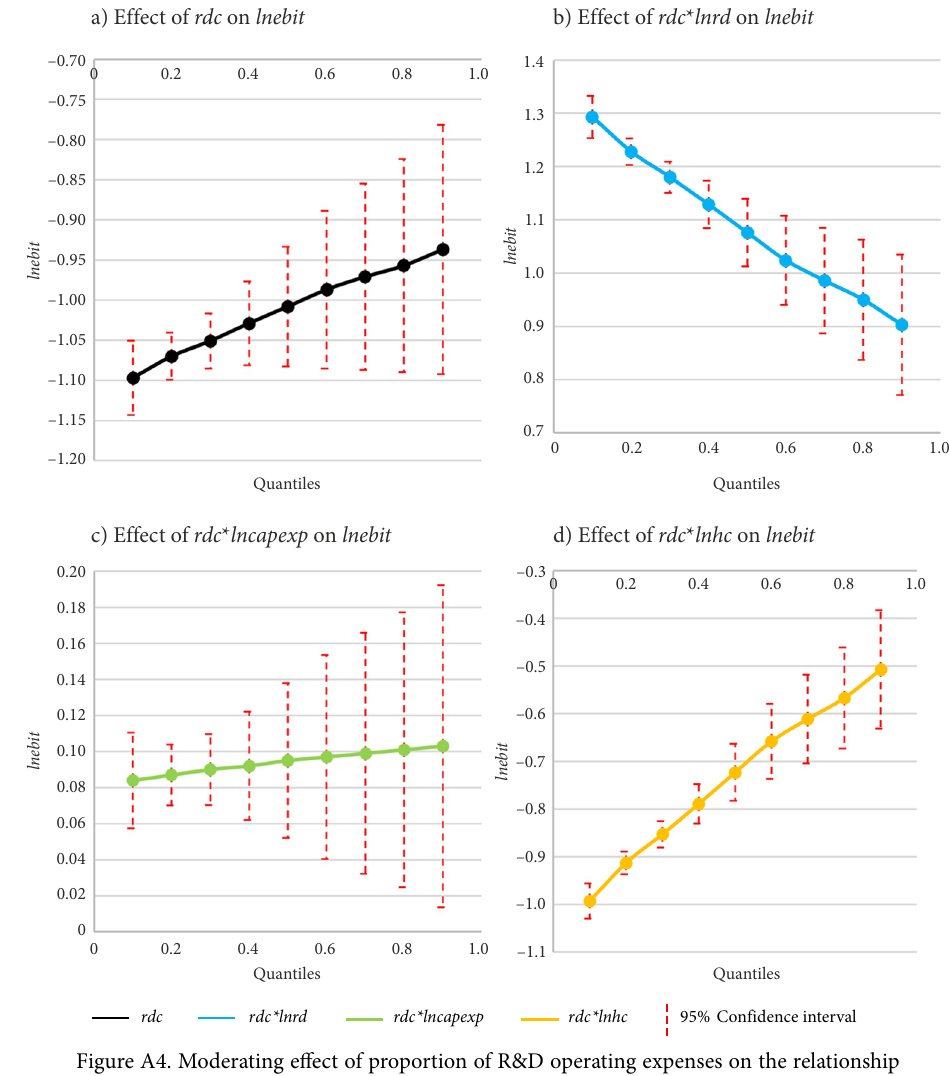
Figure A4. Moderating effect of proportion of R&D operating expenses on the relationship between three uses of government subsidies and economic